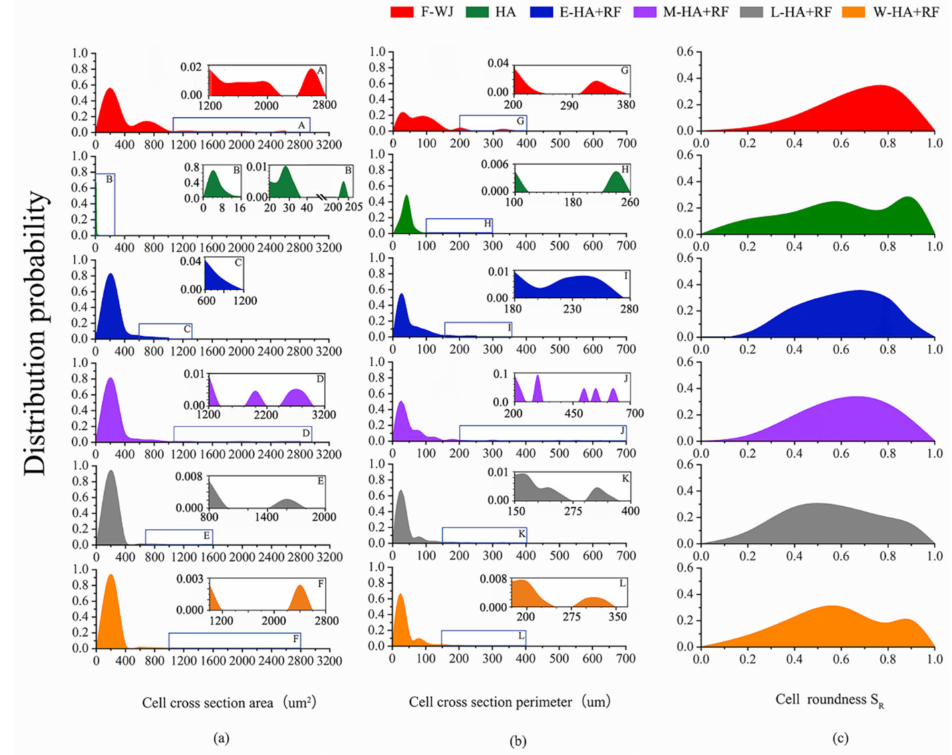
Figure 7. Microstructural data of the six groups of jujube slices (( a ): cell cross-section area; ( b ): cell cross-section perimeter; ( c ): cell